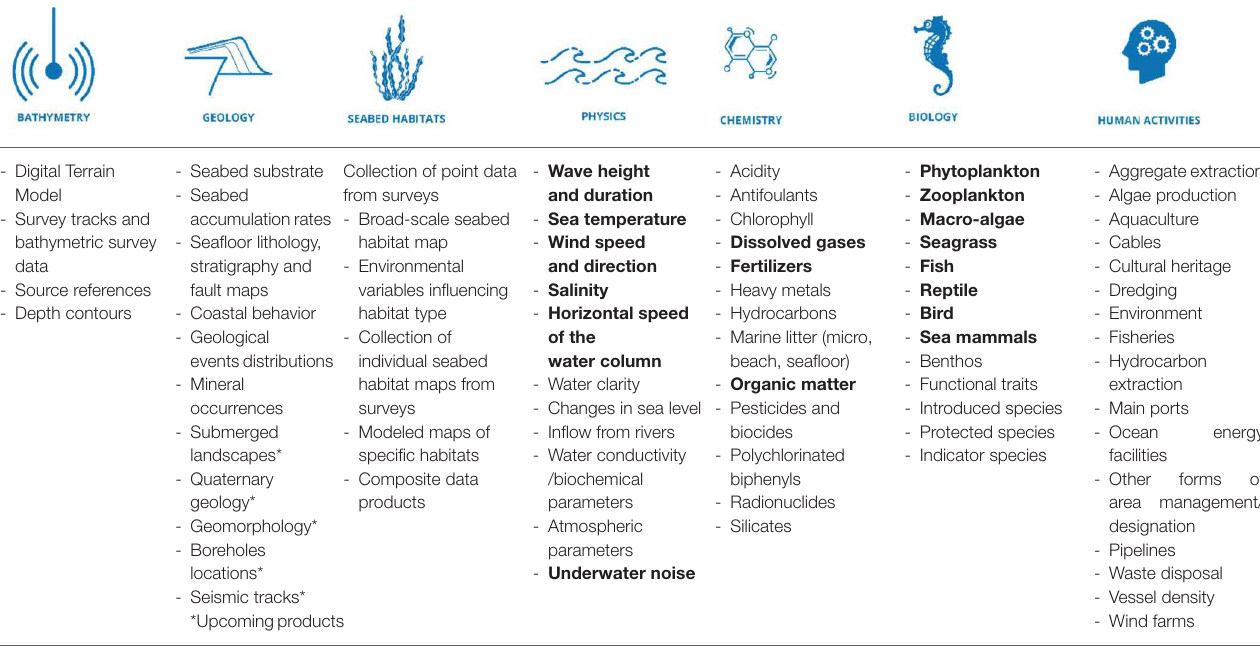
- Digital Terrain Model